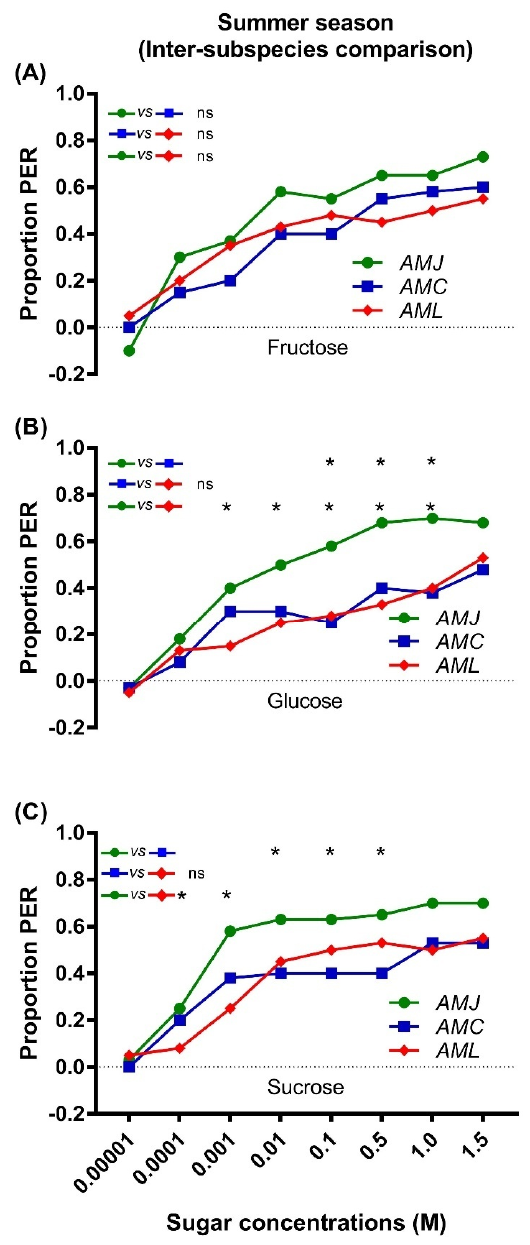
Figure 2. Comparison of the response to fructose ( A ), glucose ( B ) and sucrose ( C ) among honey bee subspecies during the summer season. Asterisks indicate the significant difference ( x 2 or Fisher’s exact test * p < 0.05 ) between the responses of honey bee subspecies ( AMJ vs. AMC , AMC vs. AML and AMJ vs. AML ) to different concentrations of each sugar type.